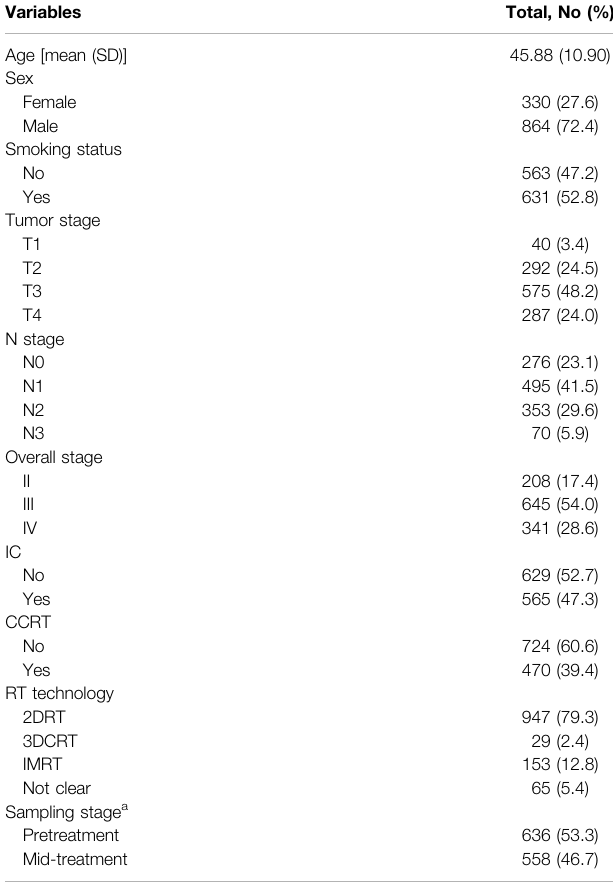
TABLE 1 | Clinical characteristics of 1,194 locoregional advanced NPC